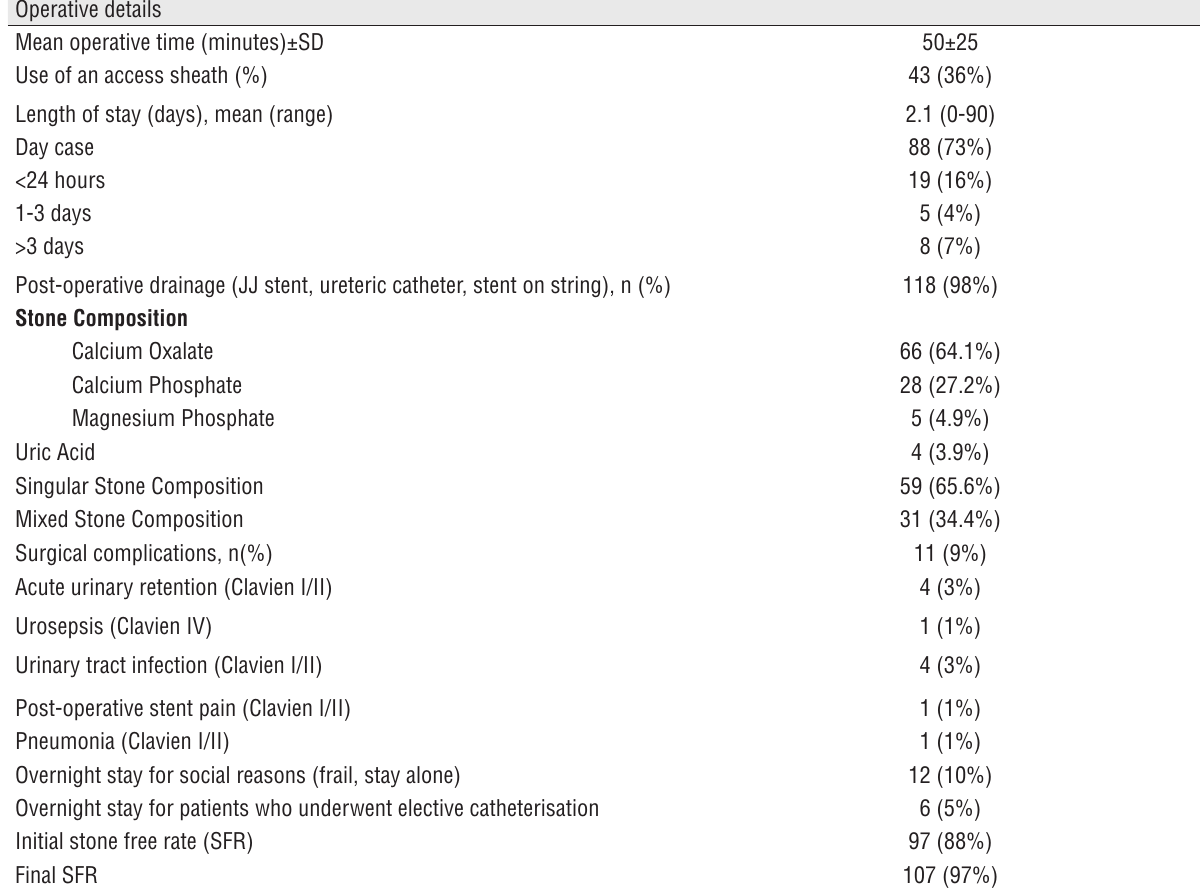
Table 2 - Operative details and patient outcomes.